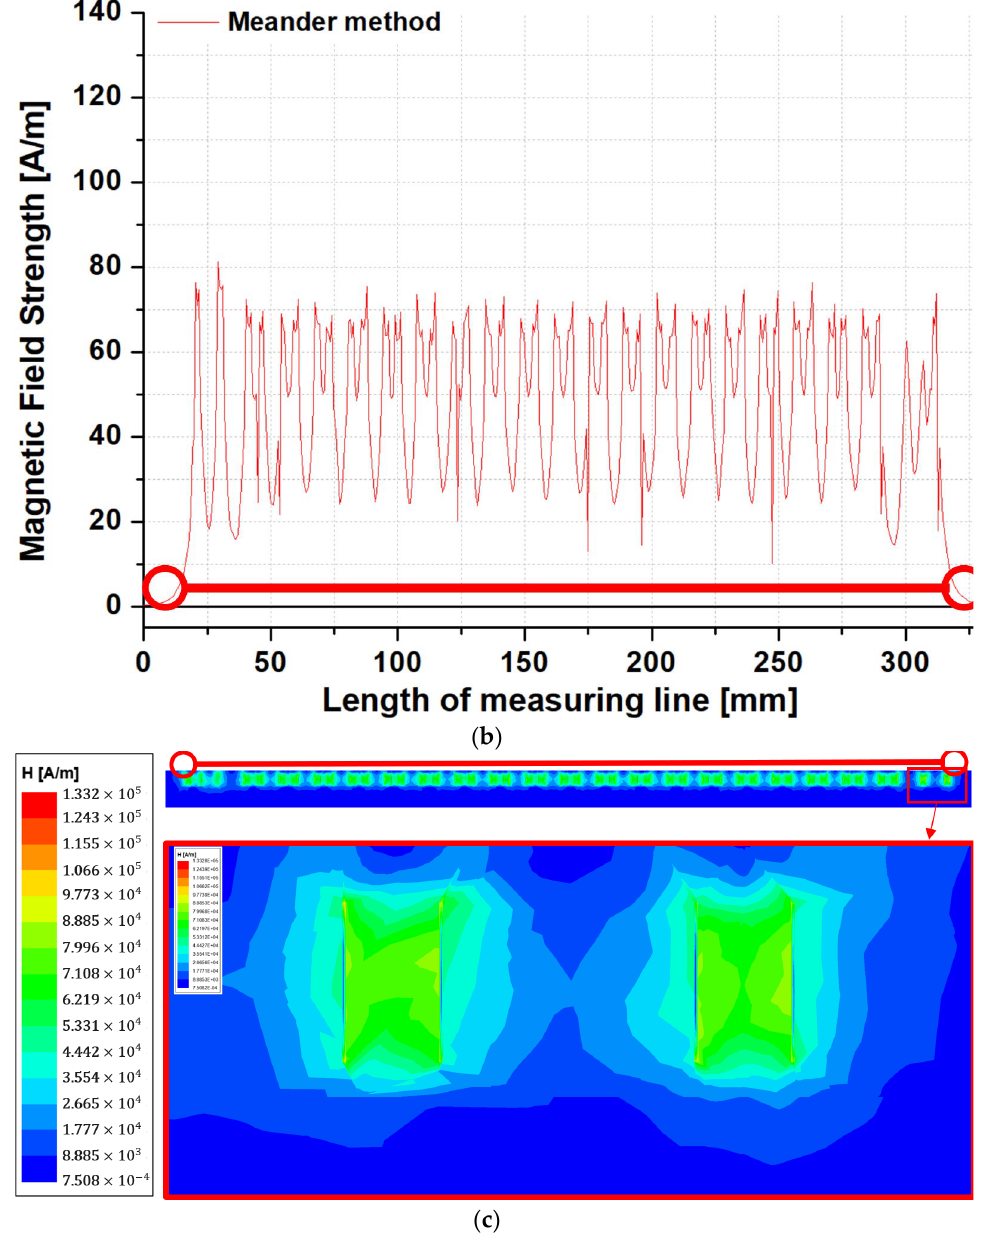
Figure 14. Magnetic field distribution diagram of bifilar-meander type: ( a ) the magnetic field distribution, ( b ) the strength of the magnetic field, ( c ) the distribution map of the magnetic field generated from some superconducting wires.